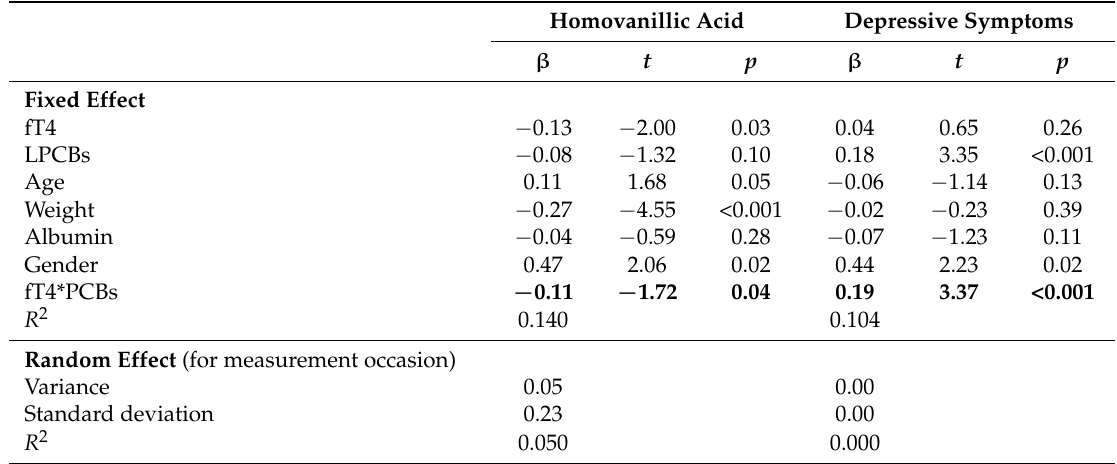
Table 4. Fixed and random effects of the moderation of log transformed and lipid adjusted LPCBs on the association of fT4 with homovanillic acid and depressive symptoms.